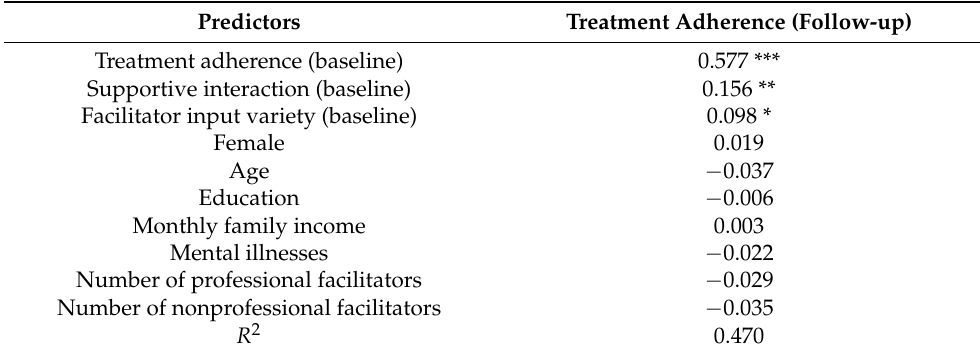
Table 3. Standardized effects of the baseline survey